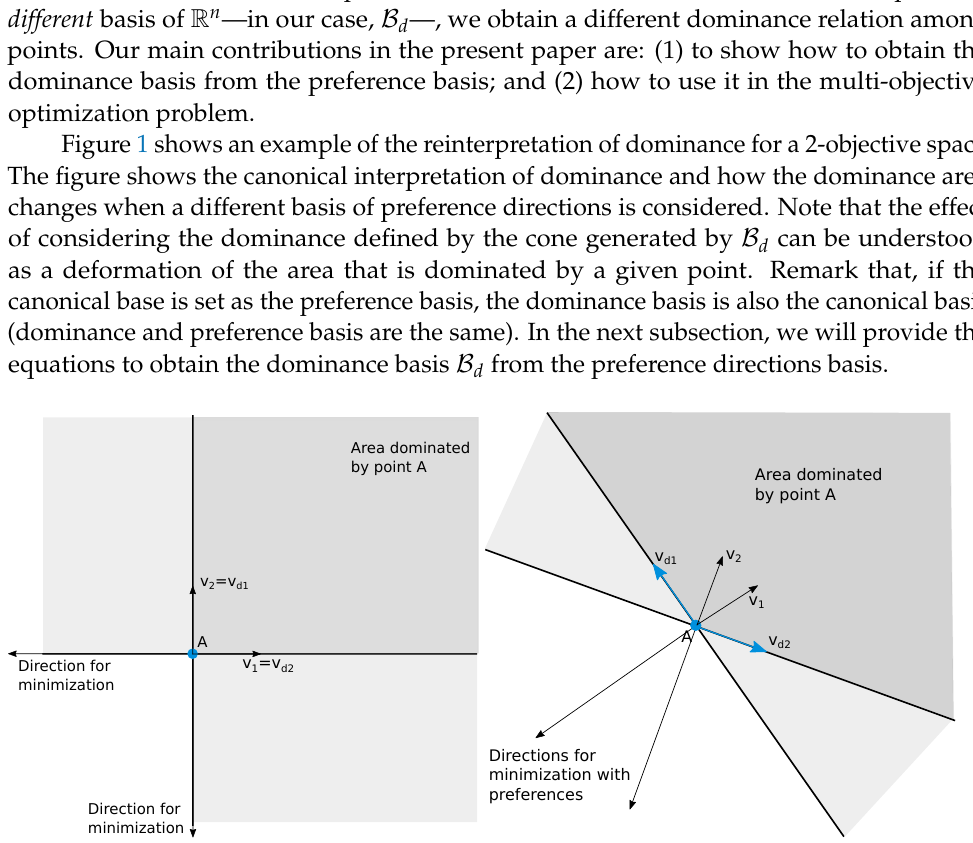
Figure 1. Graphical interpretation of canonical dominance and dominance with preferences. Domi- nated area by point A for different dominance basis ( v d 1 , v d 2 ). Dominance with the canonical basis (figure on the left ) and dominance when preferences are included with a basis change (figure on the right